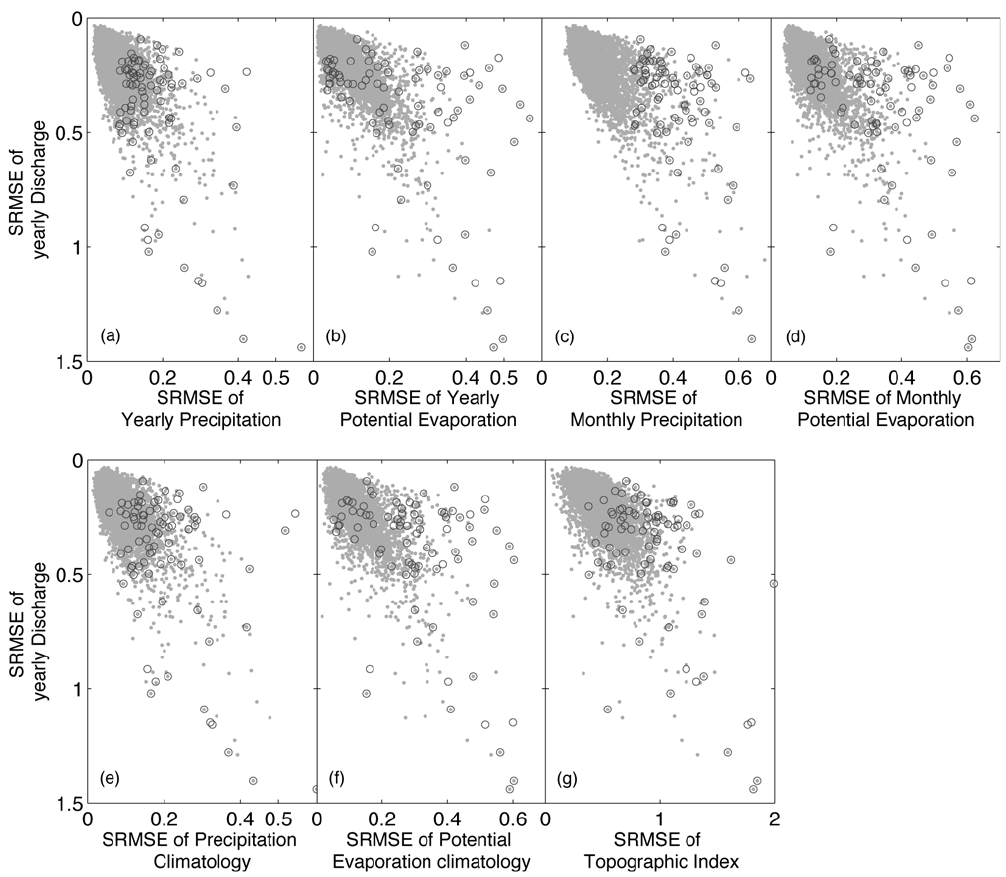
Fig. 3. The standardised root-mean-square error (SRMSE) of yearly discharge (1975–2001) calculated between sub-sets of the gauged area and the gauged area itself ( y axis), plotted against SRMSE of seven hydrological controlling factors also calculated between subsets of the gauged area and the gauged area itself. Sub-sets were selected in two different ways: (1) by using individual source sub-basin alone (black circles) and (2) by randomly combing source sub-basins (grey dots). The seven hydrological controlling factors are yearly precipitation (a) and potential evaporation (b) , monthly precipitation (c) and potential evaporation (d) , precipitation (e) , and potential evaporation climatology (f) and the frequency distribution of topographic index (g)